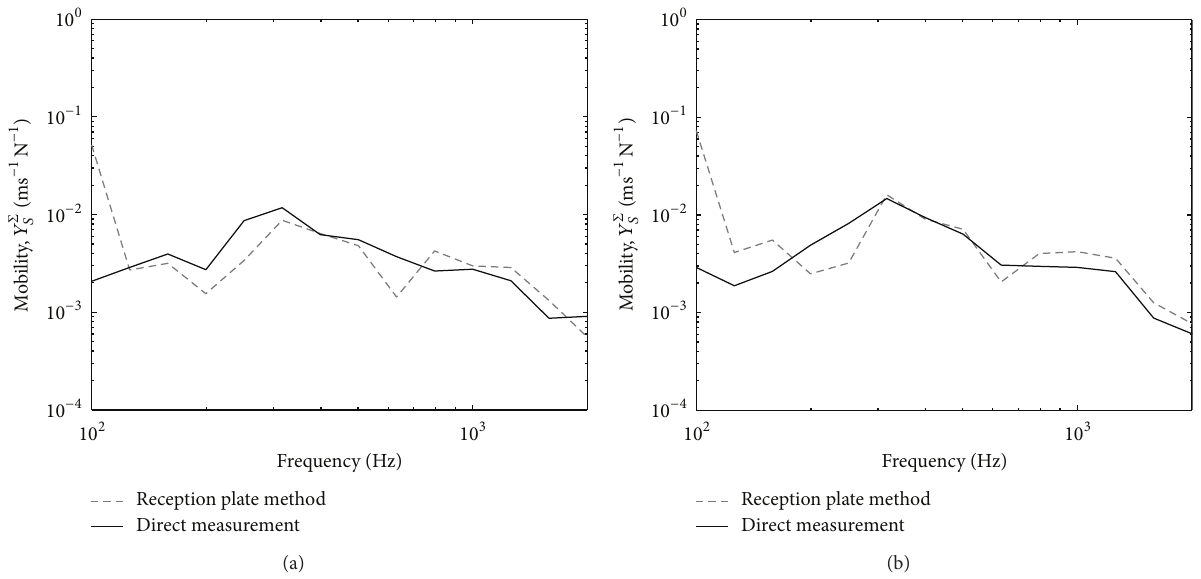
Figure 16: Comparison of the squared free velocity obtained by the reception plate method (thick line) and direct measurement (thin line): (a) zero phase and (b) random